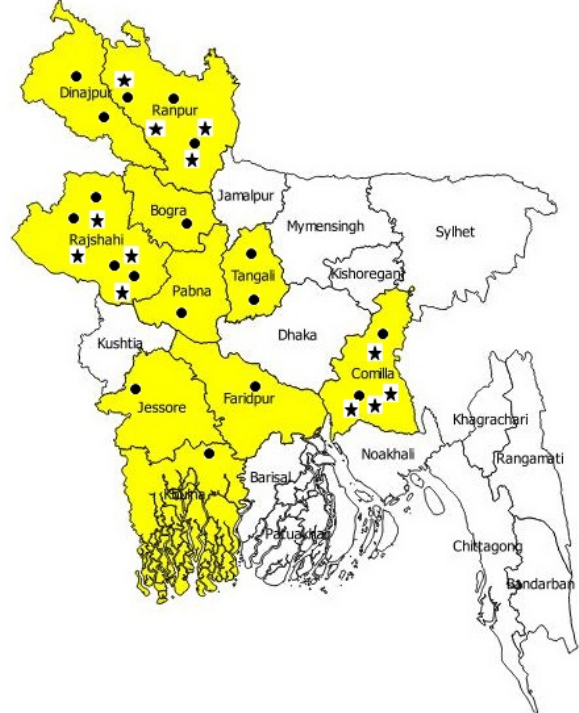
Figure 1. Dots showing the locations for 18 soil samples collected from various districts for pot experiment and stars showing the field experimental sites in